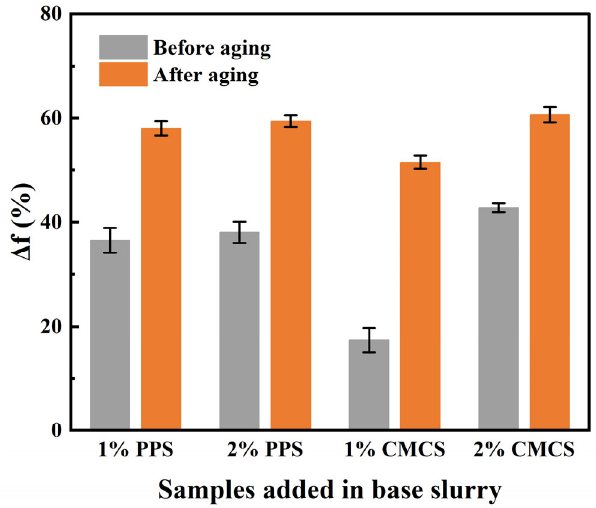
Figure 10. Lubricity performance of PPS and CMCS under different dosages.